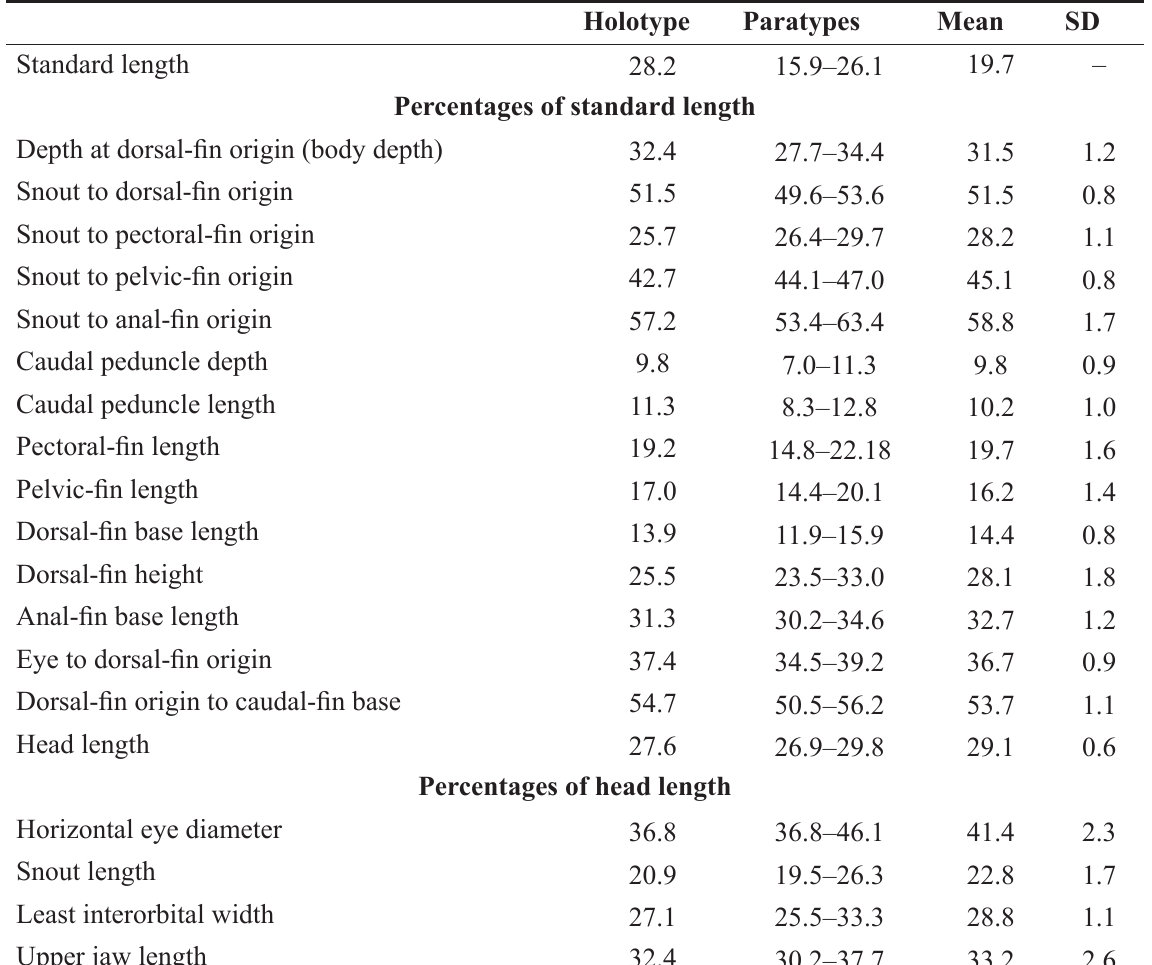
Table 3. Morphometric data (N = 53) for the holotype and paratypes of Hyphessobrycon geryi Guimarães, Brito, Bragança, Katz & Ottoni sp. nov. SD = Standard